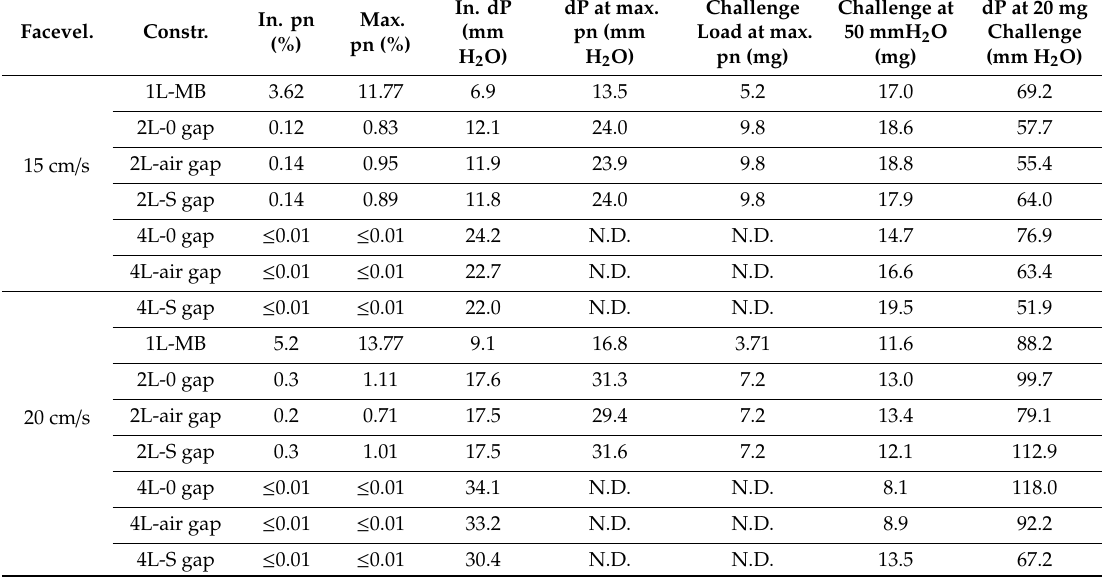
Table 3. Summary of loading performance of di ff erent filter constructions. Facevel.